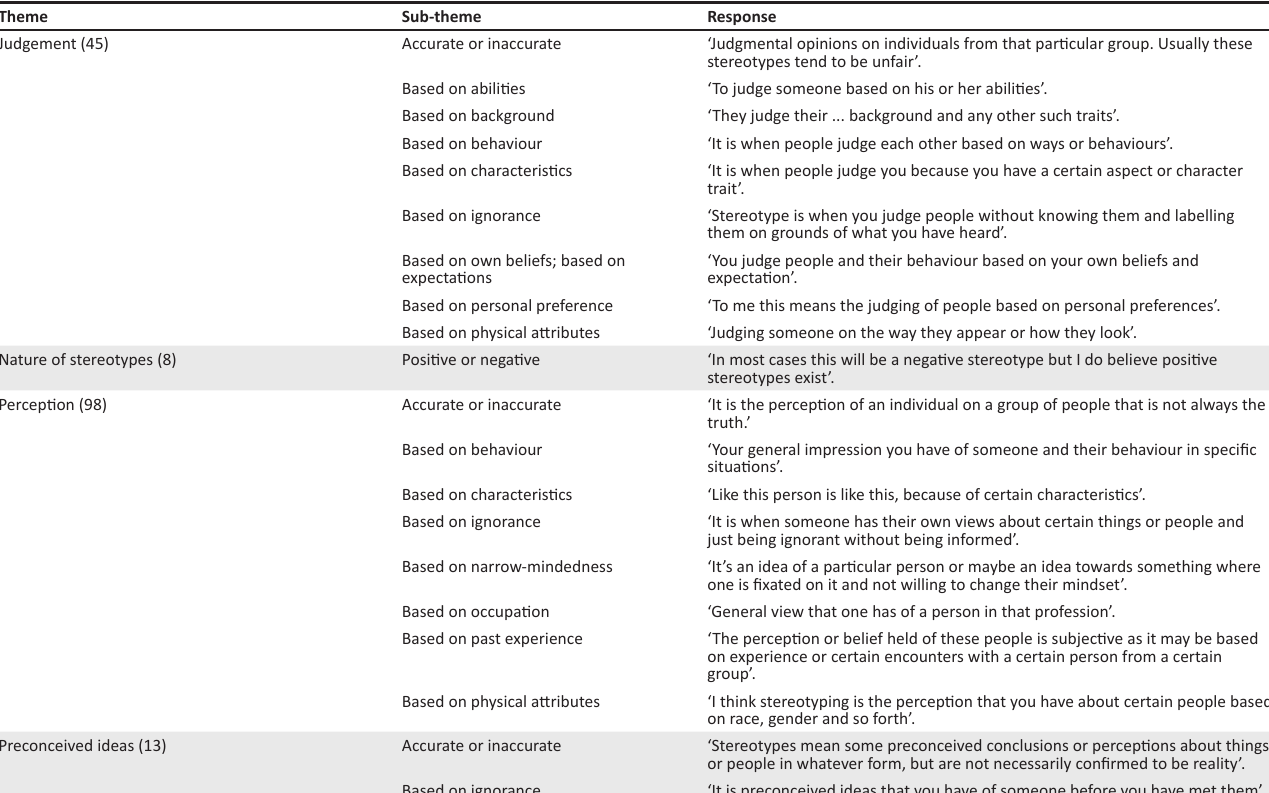
TABLE 2 (Continues...): Meaning of